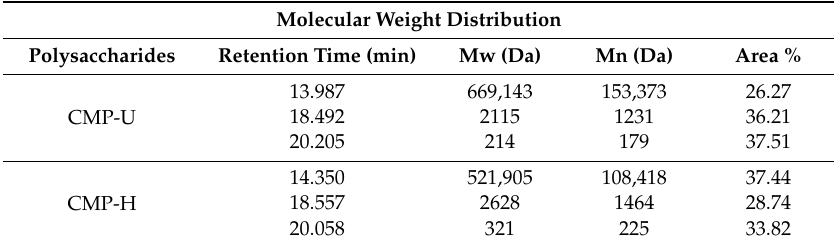
polysaccharides obtained by ultrasonic assisted extraction.